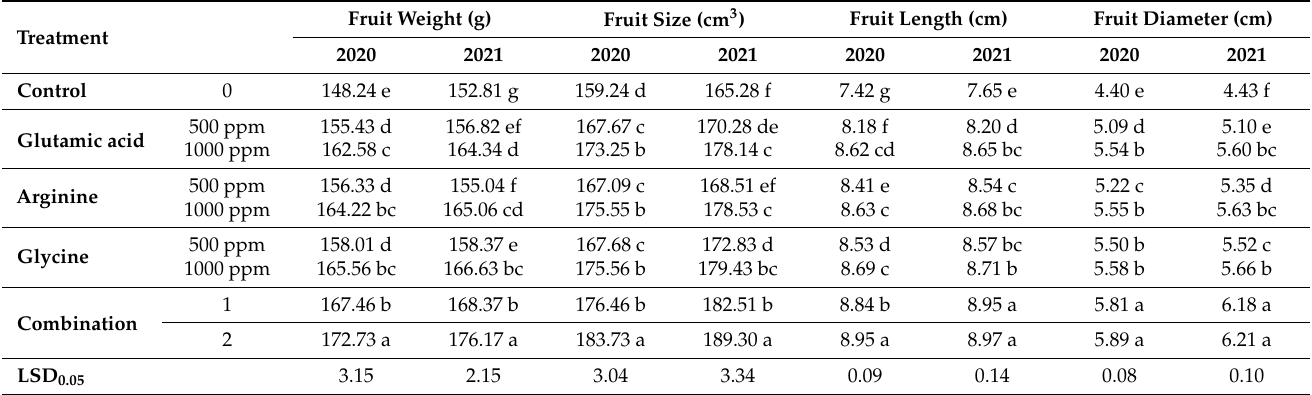
(500 ppm) at improving fruit weight, size, length, and diameter in the 2020 and 2021 study seasons. Table 3. The influence of glutamic acid, arginine, and glycine amino acids on fruit weight, size, length and diameter of guava during the 2020 and 2021 seasons.